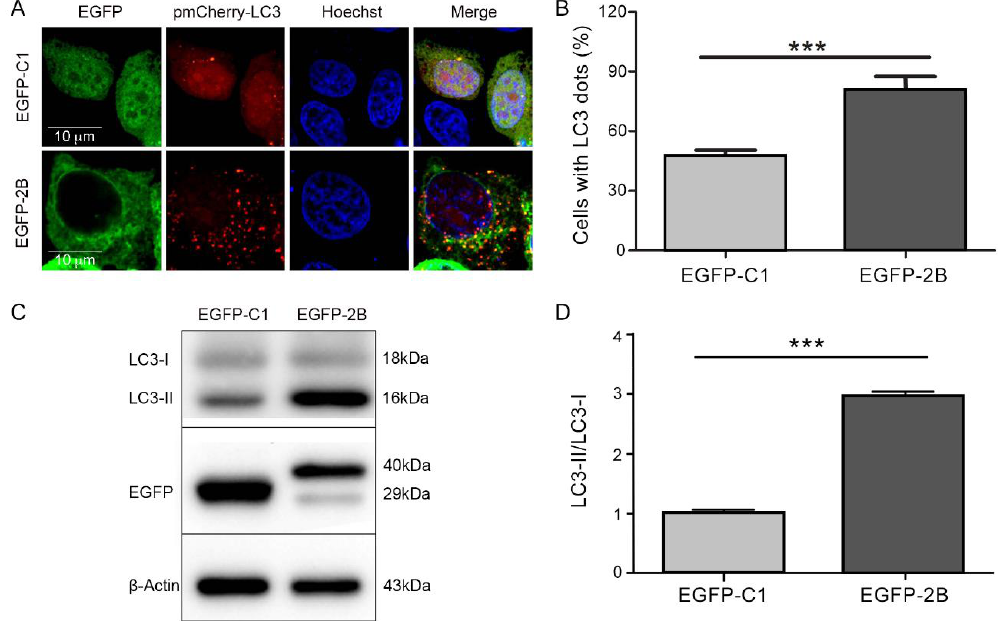
Figure 2. Protein 2B of CVB3 induces autophagy. ( A ) HeLa cells were co-transfected with pEGFP-2B and pmCherry-LC3 for 48 h. The control cells were co-transfected with pEGFP-C1 and pmCherry-LC3. Cells were observed by confocal microscope (×600); ( B ) cells with LC3 dots were counted over the LC3-expressing cells. *** p < 0.01. Data were derived from 100 cells in each sample; ( C ) HeLa cells were transfected with pEGFP-2B for 42 h and treated with E64-D/PEPA (10 ng/mL) for 6 h. Enhanced green fluorescent protein (EGFP) and LC3 were determined by Western blotting; ( D ) the ratio of LC3-II/LC3-I was calculated according to the results of Western blots. n = 4. Experiment was repeated four times. Representative images were presented.